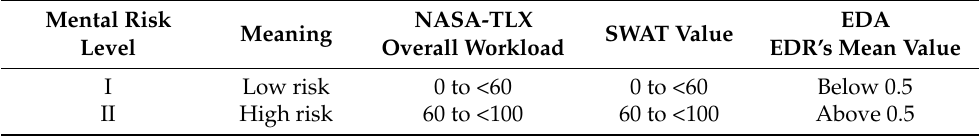
Table 2. Mental risk levels based on the output scores of each